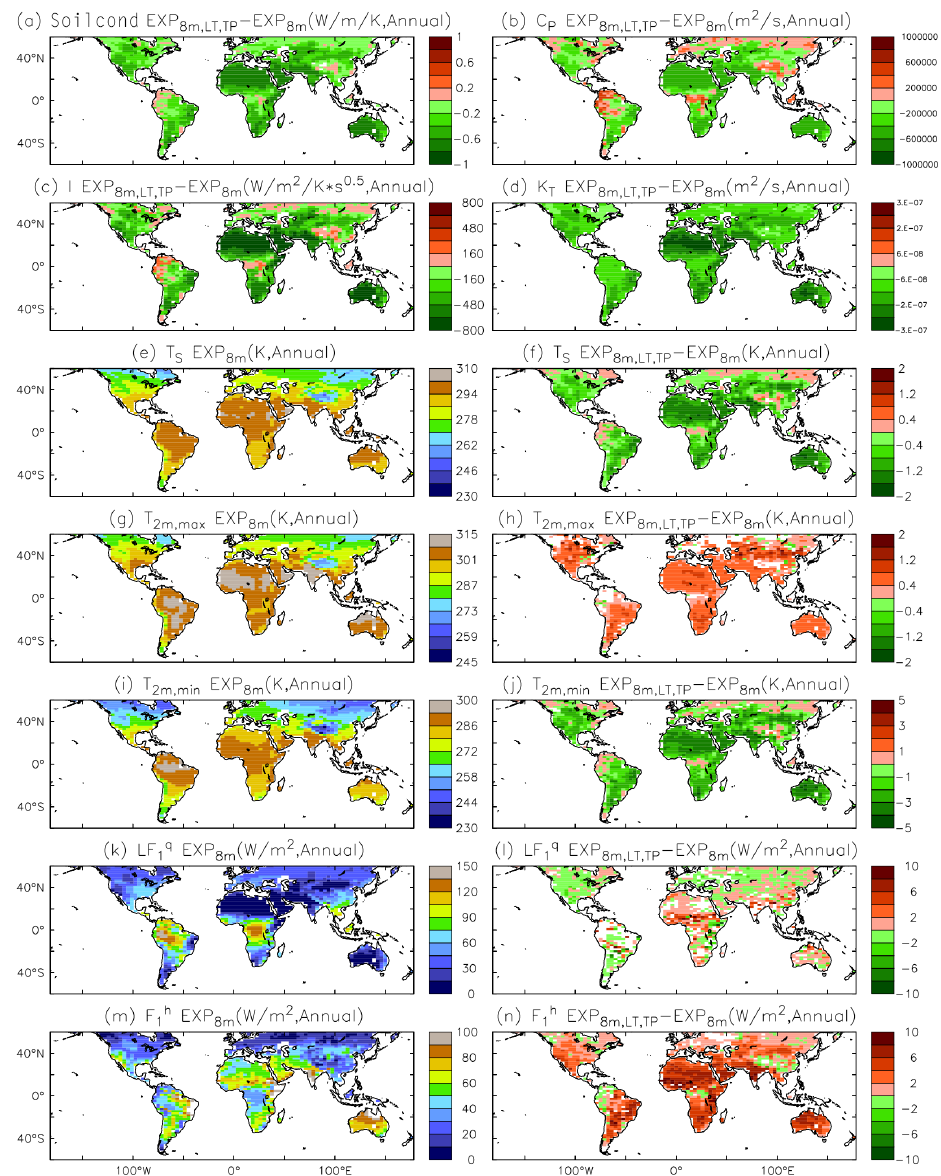
Figure 8. The LMDZOR simulations (annual mean) for EXP 8m (left) and the differences between EXP 8m , LT , TP (Table 4) and EXP 8m (right) for (a) soil thermal conductivity, (b) soil heat capacity, (c) soil thermal inertia, (d) soil heat diffusivity, (e, f) surface temperature, (g, h) daily maximum temperature, (i, j) daily minimum temperature, (k, l) latent heat flux, and (m, n) sensible heat flux. The white regions indicate that the new parameterizations are not